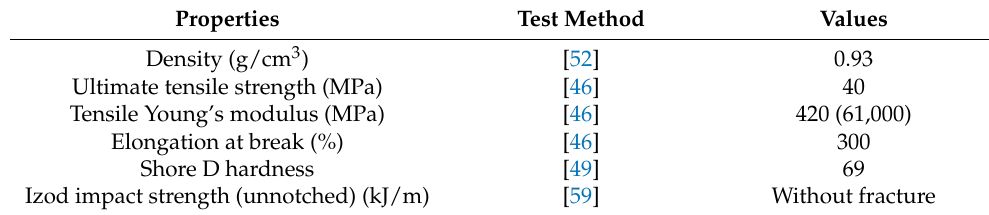
Table 15. The properties of the ‘TIVAR ® 88’ material fabricated by ‘Mitsubishi Chemical Ad- vanced